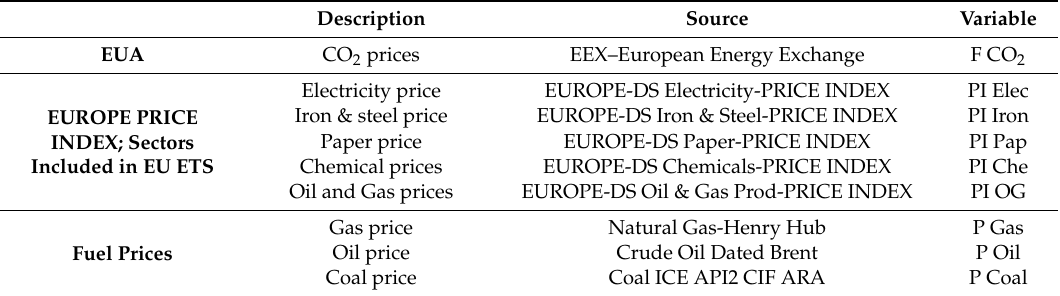
Table 1. Variables analyzed to determine the influence of energy or raw materials on the forecasting accuracy of prices of CO 2 emission